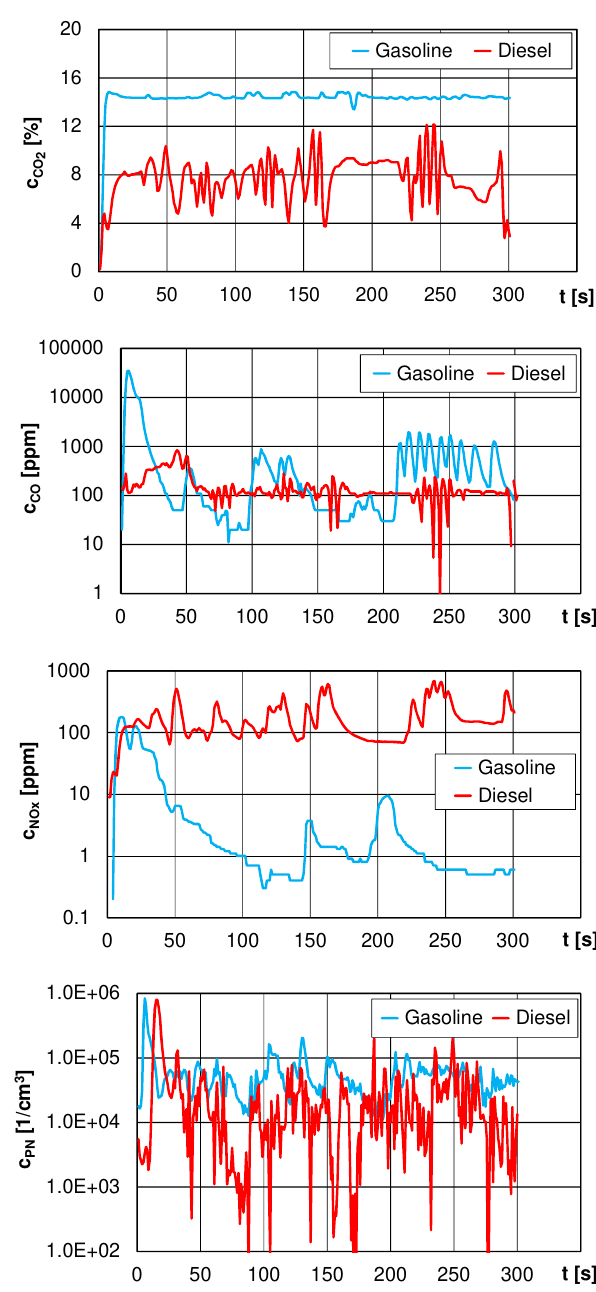
Fig. 10. The change of exhaust gases concentration during 300 s from the cold start for gasoline and diesel engines: carbon dioxide, carbon mono- xide, nitrogen oxides, and particles